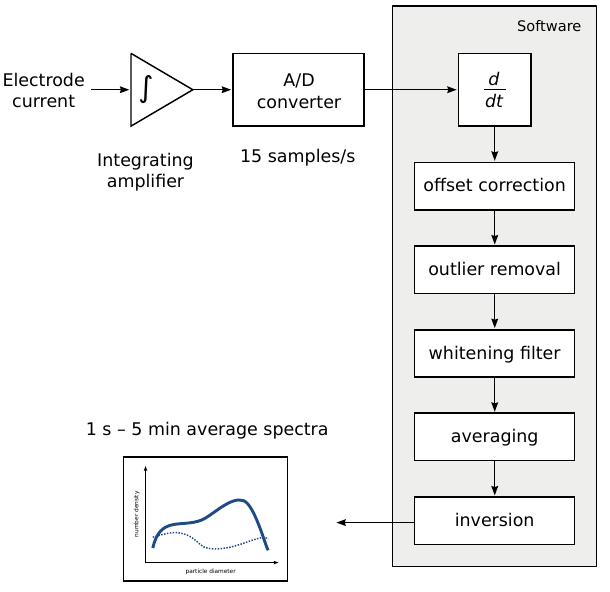
Fig. 6. Signal and data-processing flow diagram of the NAIS.